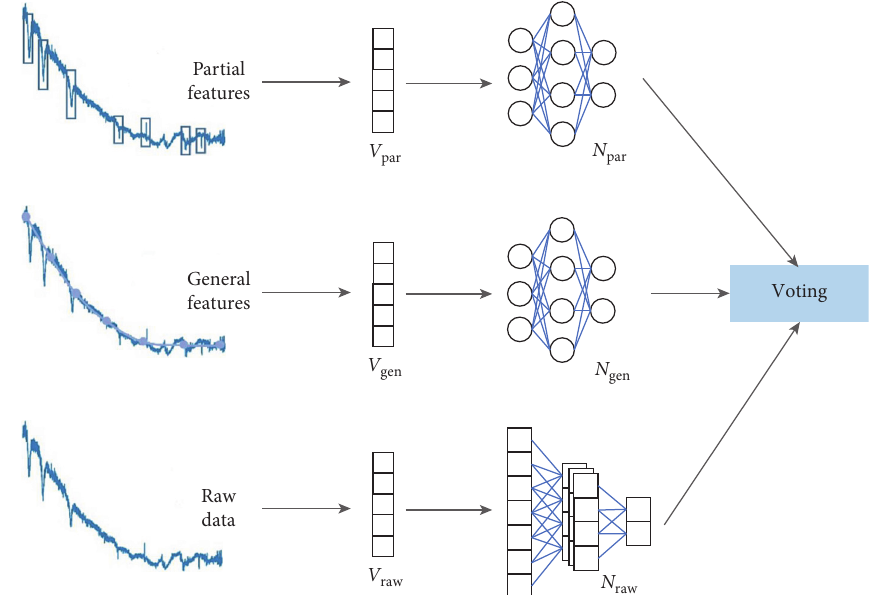
Figure 2: Experimental model